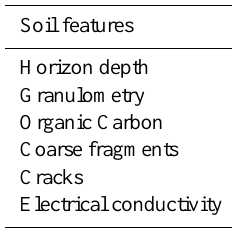
Table 4b. Directly usable soil features commonly occurring in databases and exploitable in hydrological